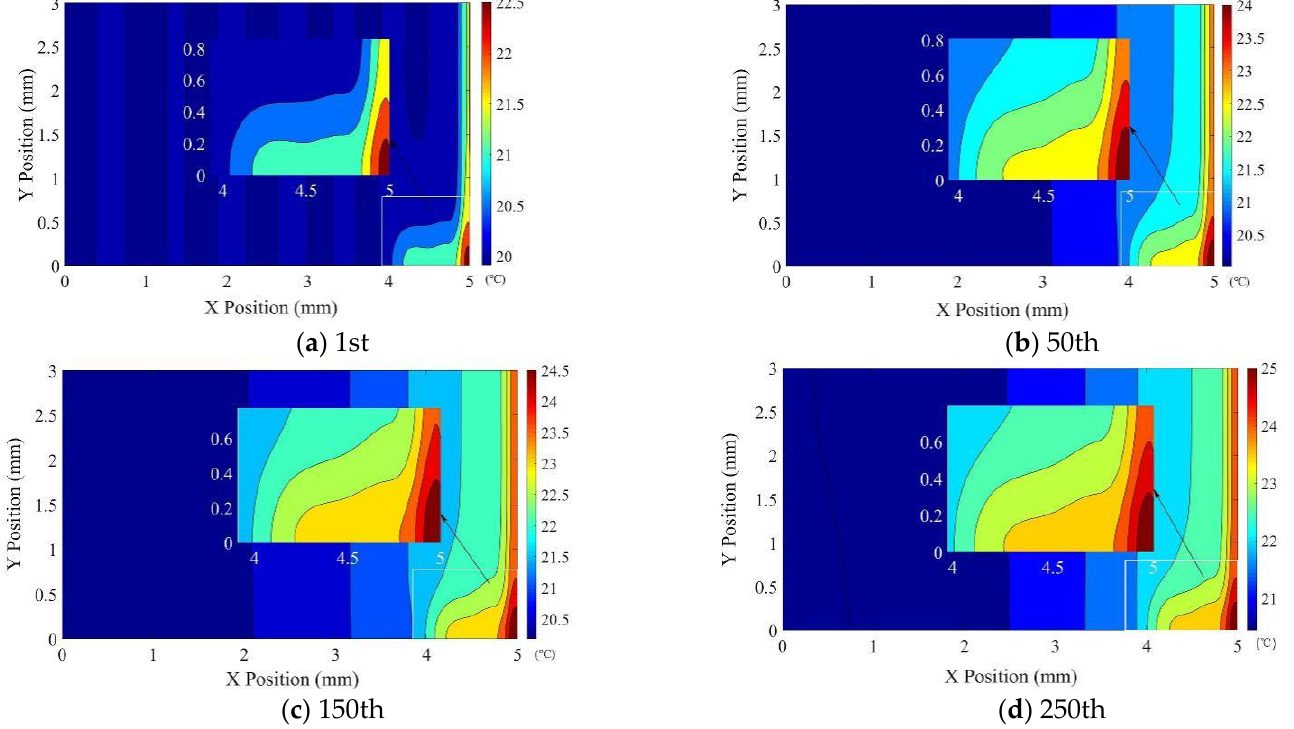
Figure 19. Temperature gradient of the X–Y direction section of the tool nose region.